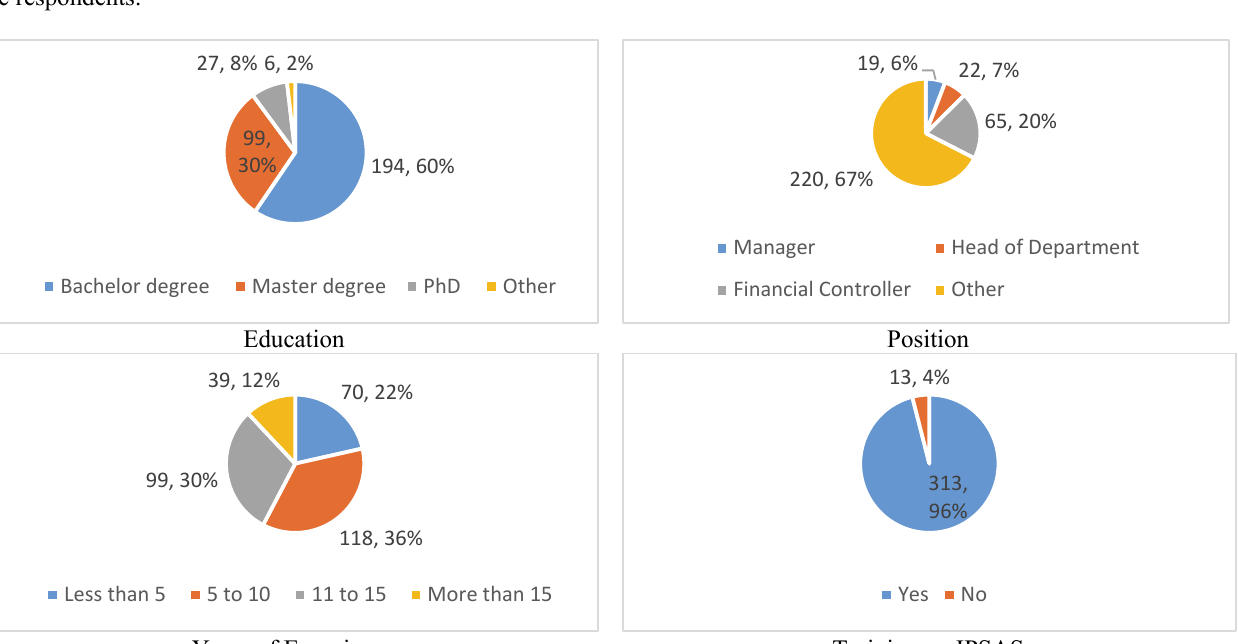
Fig. 1. Personal characteristics of the